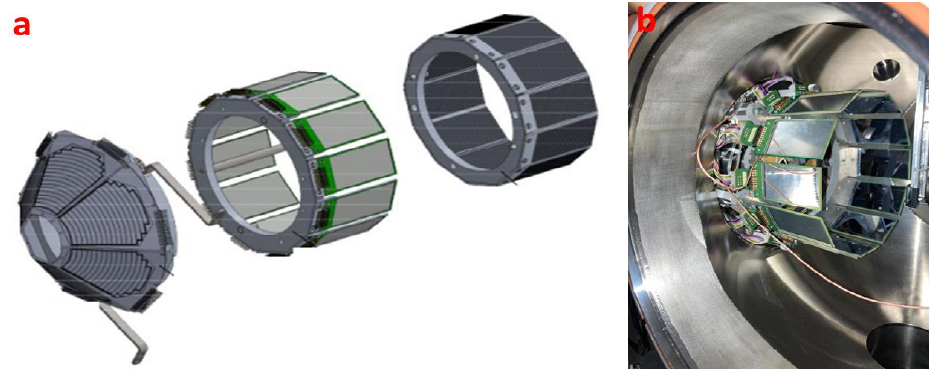
Fig. 2. (a) Schematic drawing of the ELISSA+LHASA experimental setup, and (b) the ELISSA+LHASA detector array in a reaction chamber at the 3 MV tandem accelerator of IFIN-HH. Photograph courtesy of Teodora Madgearu.